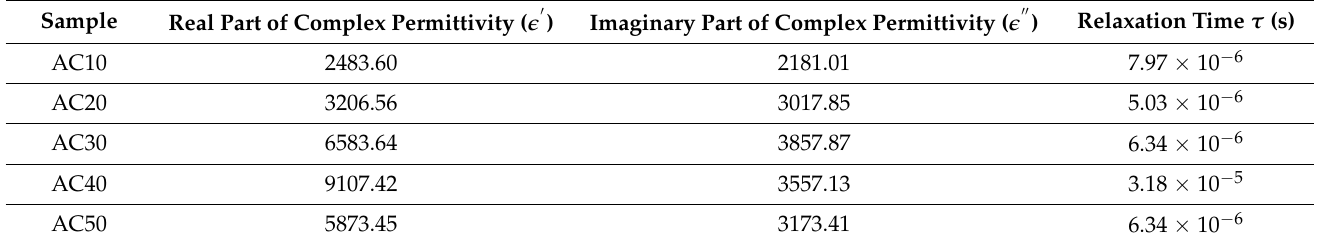
Table 2. Variation of real and imaginary parts of complex permittivity at 10 Hz and relaxation time as a function of salt